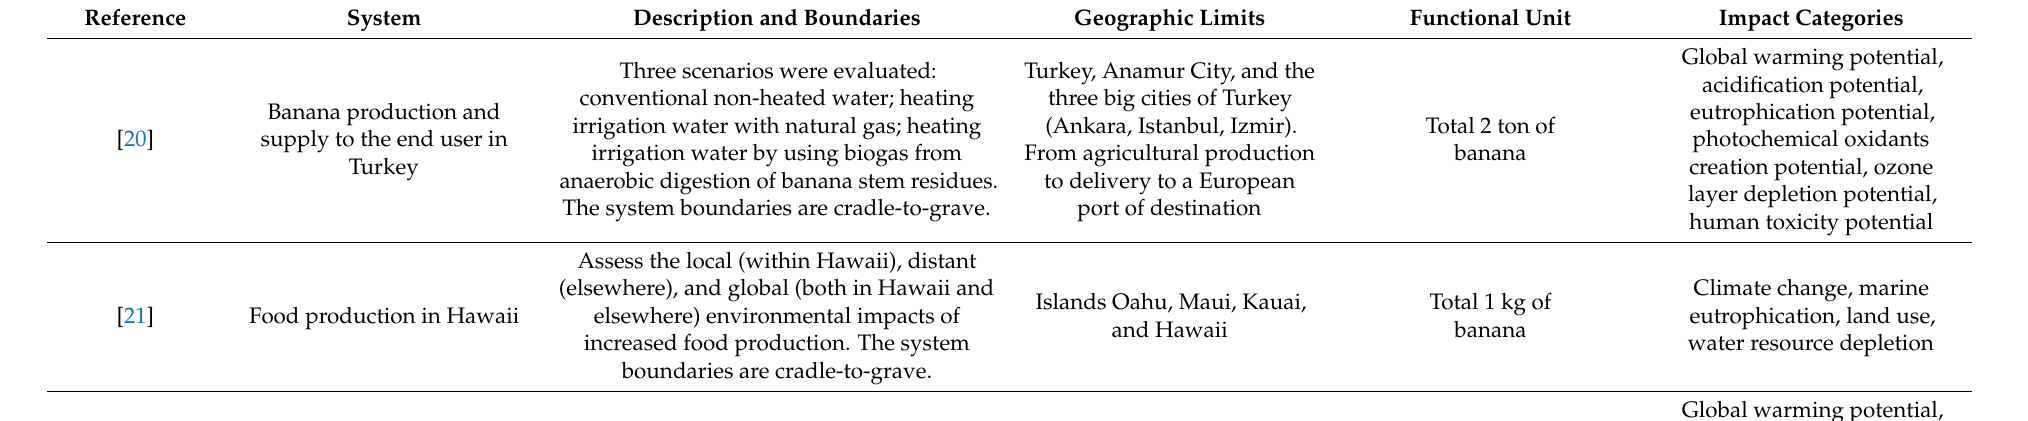
Table 1. Overview of life cycle assessment studies of banana reported in peer-reviewed